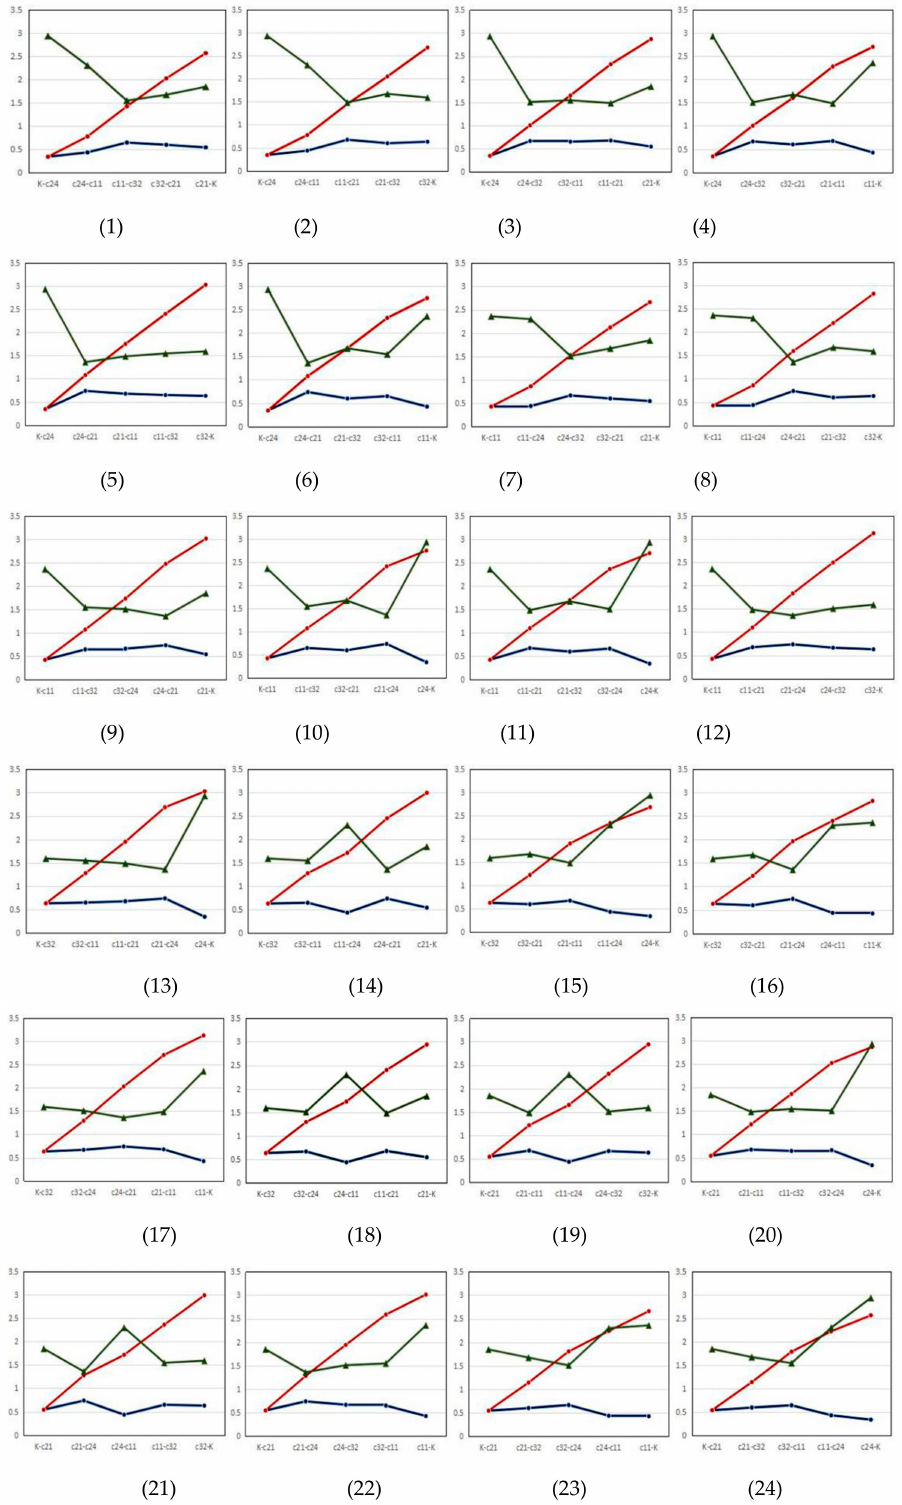
Figure 7. Sub-unit motive function I ( · ) fluctuating curves ( green color ), sub-unit motive weight value h ( · ) fluctuating curves ( blue color ) and generation tree weight function L ( · ) fluctuating curves ( brown color